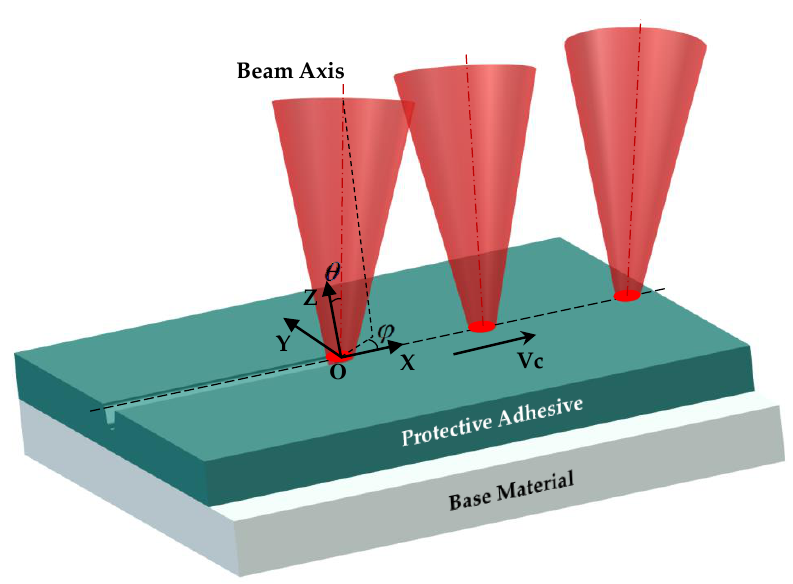
Figure 7. The schematic diagram of 5-axis variable-angle laser engraving.